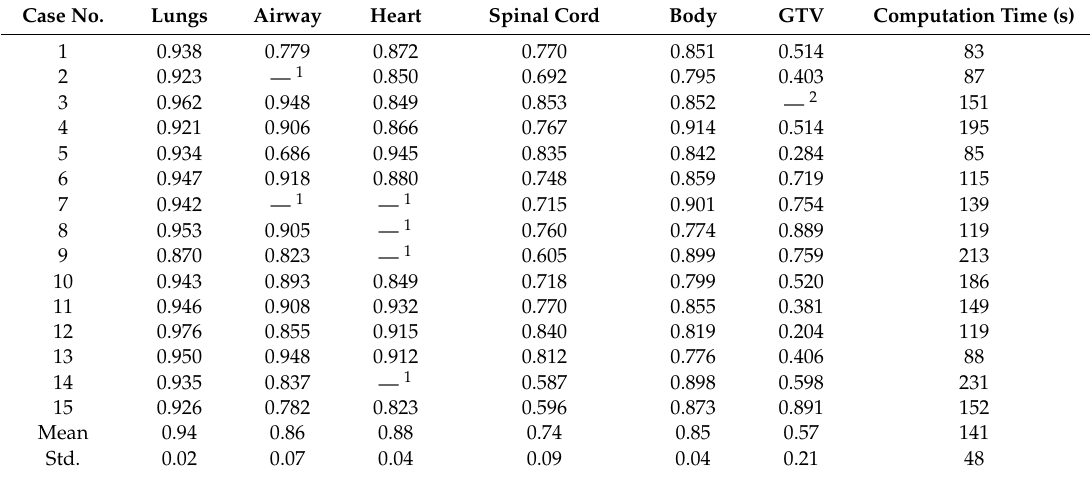
Table 2. Dice coe ffi cients of six targets in dataset I.